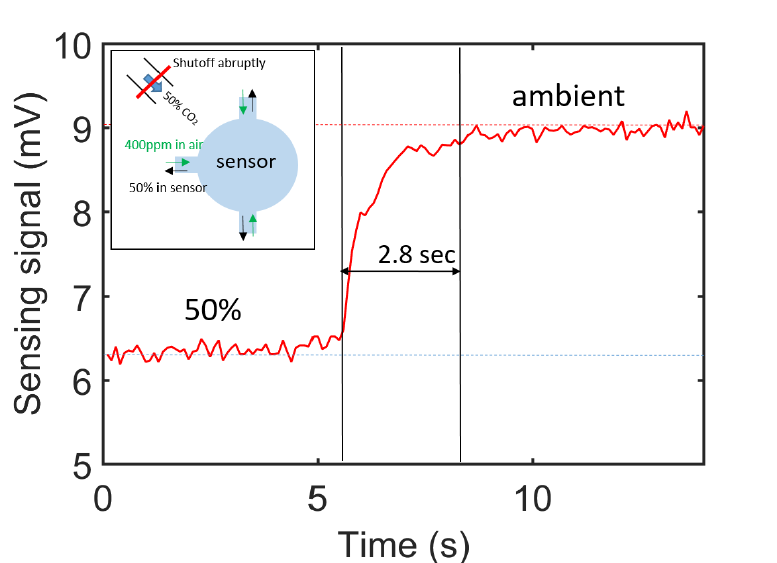
Figure 10. Response time of sensor, measured with 100 ms lock-in integration time. The inset shows the gas flow mechanisms when the 50% CO 2 is abruptly shut